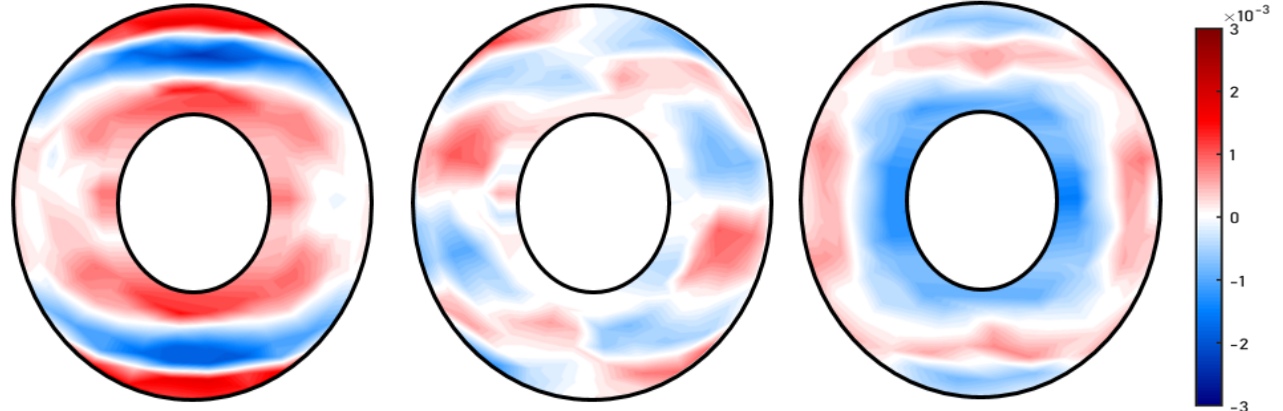
Figure 17. Two-dimensional strain components ε xx , ε xy , ε yy respectively with KOWARI